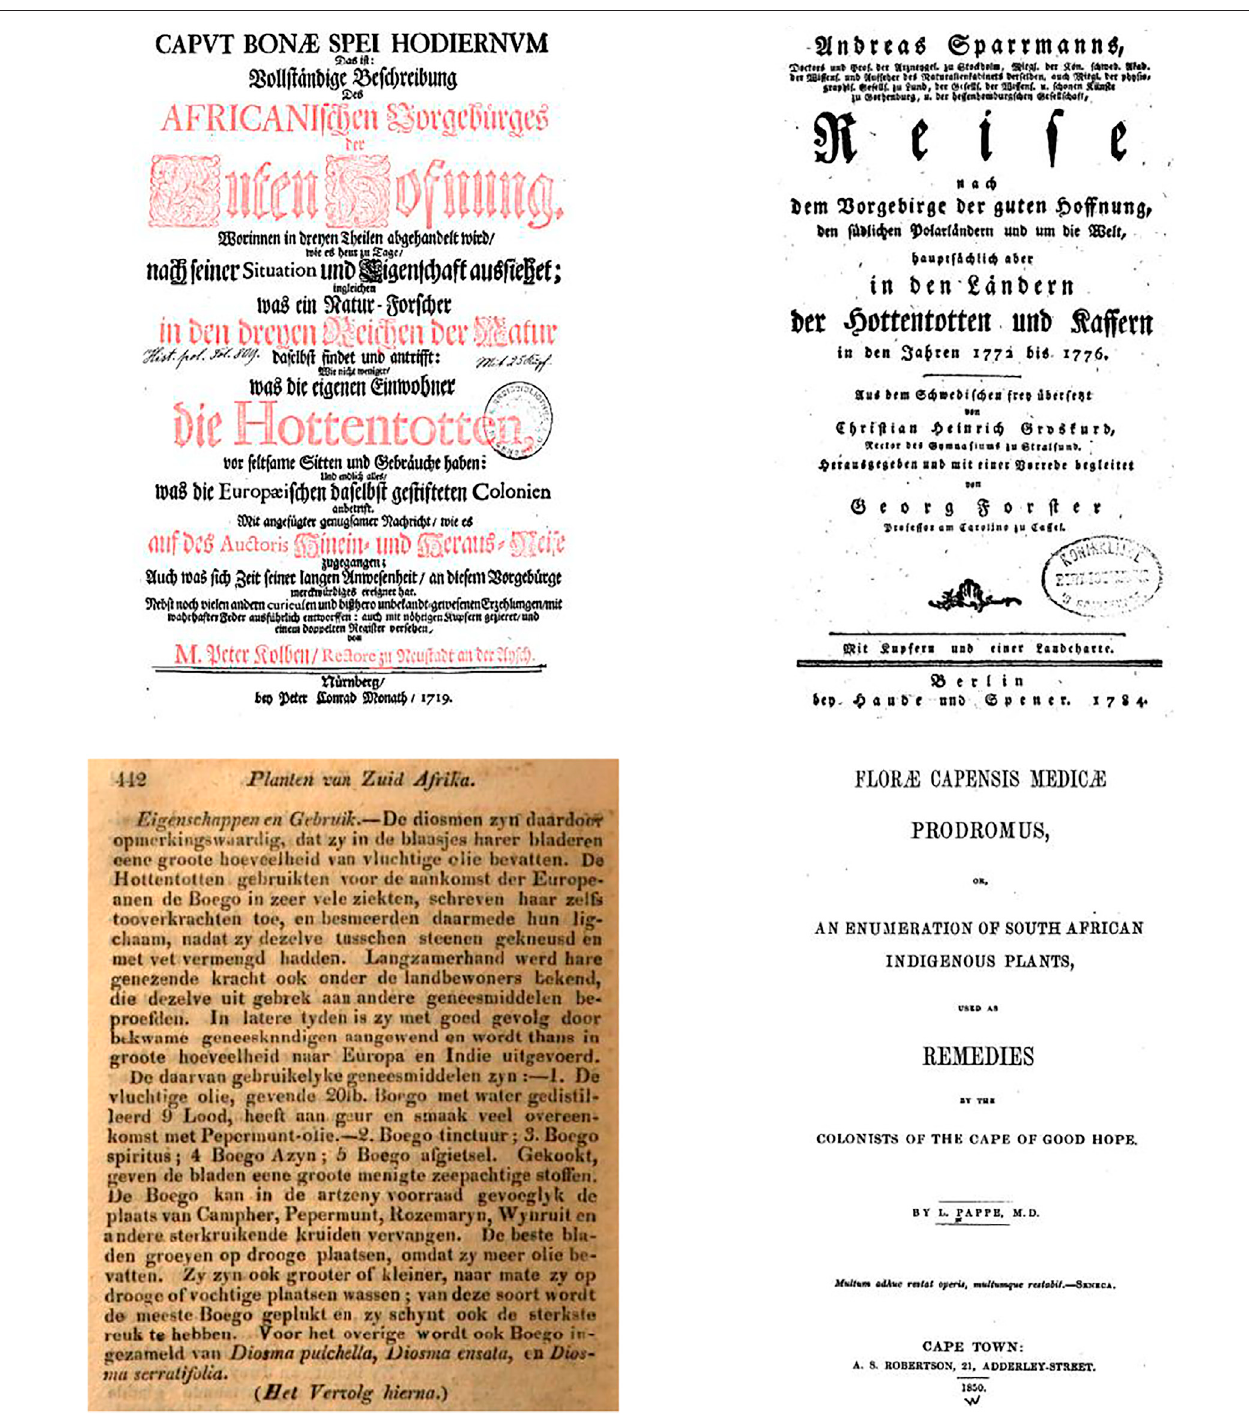
FIGURE 2 | Title page of Kolb (1719), title page of Sparrmann (1784), excerpt from Ecklon (1826), title page of Pappe (1850).